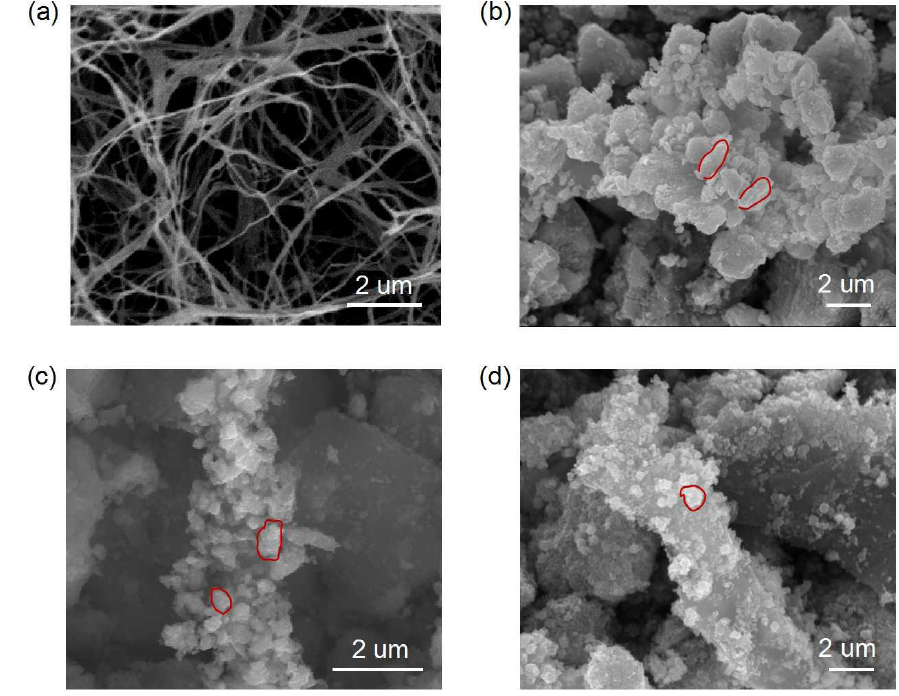
Figure 3. SEM images of ( a ) PBC, ( b ) CFO@KB, and ( c , d ) CFO@PBC.